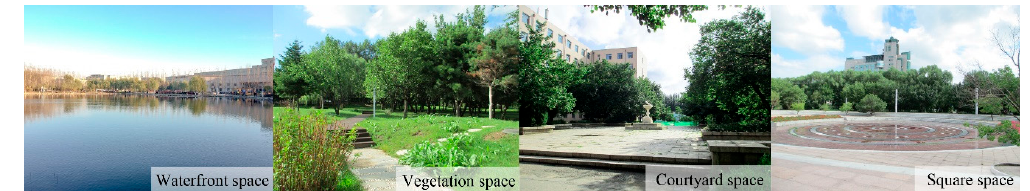
Figure 1. Examples of landscape types of university campus (from sample 3).